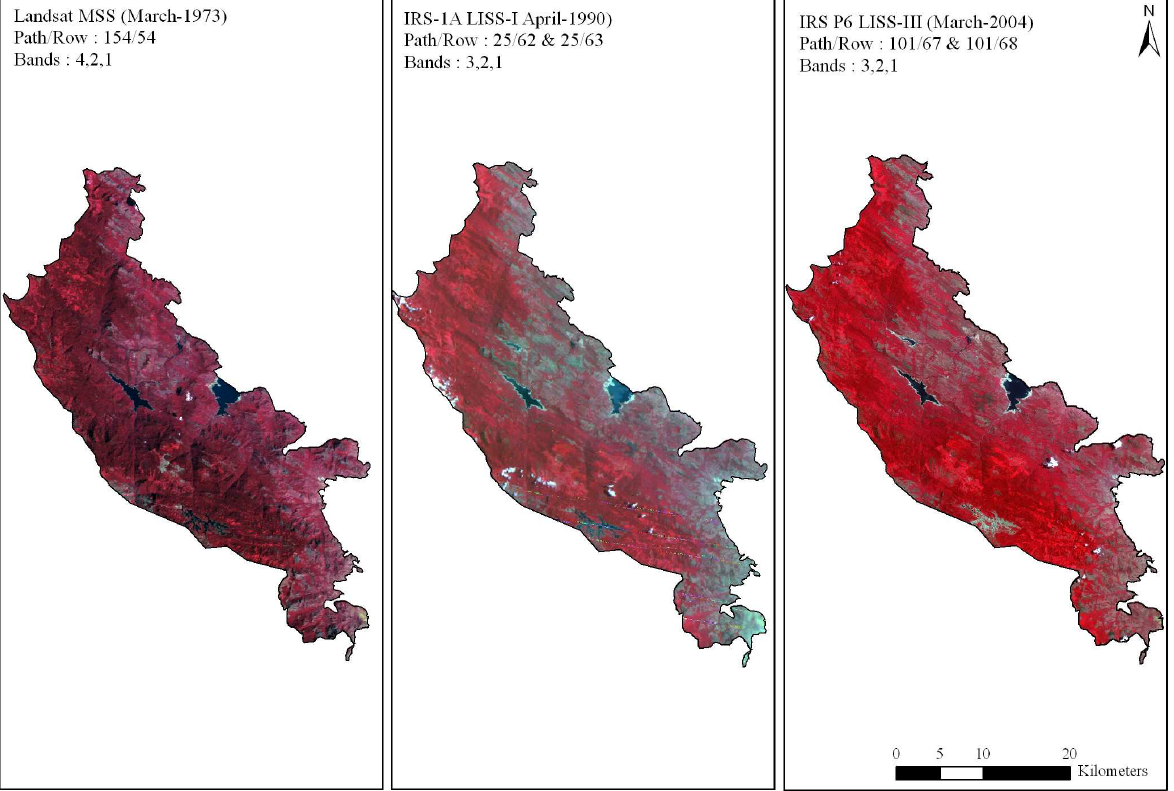
Figure 2. False color composites for the study region between 1973 to 2004 showing different vegetation formations, and also the variation in tone and texture in the South Western Ghats, Tamil Nadu,